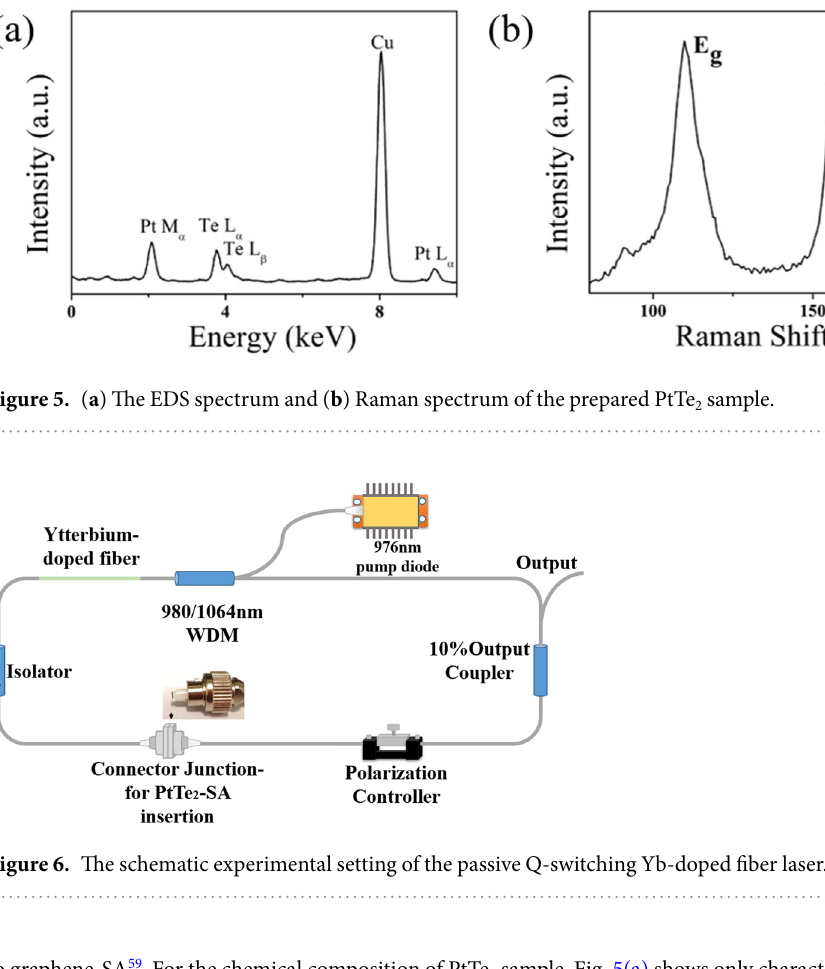
to graphene-SA 59 . For the chemical composition of PtTe 2 sample, Fig. 5(a) shows only characteristic peaks from Pt or Te and no other observable impurities is found (Cu peak is induced from the copper mesh support for TEM measurement). Meanwhile, as shown in Fig. 5(b), the Raman-active modes E g and A 1g were positioned at 110.7 cm − 1 and 154.8 cm − 1 , respectively, and which agree well with the previous report 57 . The E g mode is repre- senting the in-plane vibration mode of Platinum and Ditelluride atoms. Meanwhile, the A 1g is standing for the out-plane vibration modes of Ditelluride atoms. These strong characteristic Raman peaks reveal that the fabri- cated PtTe 2 nanosheets possess with good crystallinity. For the laser test, a pure Polyvinyl alcohol (PVA) film, which possess of identical thickness as the PtTe 2 -PVA SA film, was first inserted between the connector junction of the ring cavity as shown in Fig. 6 to act as a control experiment set. No Q-switched laser pulses were observed by modifying the polarization direction of the polarization controller (PC) and pumping power. It confirms Q-switching operation cannot be obtained by using pure PVA polymer or cavity phase self-modulation. Further on, the fabricated PtTe 2 -SA was cut with a size in approximately 1 mm × 1 mm, and was intro- duced into the laser system by sandwiching between two fiber connectors. The parasitic reflection could be eliminated by using FC/APC connector and thus improved the stability of the Q-switching system. Stable Q-switched pulse train was observed as the pump power elevated to the starting threshold of 118 mW. However, when the pump power raised beyond 146.5 mW, the Q-switched output was vanished due to the over saturation of the absorber at high input fluence 26,60 . The average output power was measured as from 1.03 mW to 2.48 mW with respect to the pump power from 118 mW to 146.5 mW as shown in Fig. 7(a). The modula- tion ranges of the pulse width (Full width at half maximum) and the repetition rate are 13.6 μ s to 5.2 μ s and 23.0 kHz to 33.5 kHz, respectively as shown in Fig. 7(b). The fluctuation of repetition rate and output power of the Q-switched laser are less than 5% within the test time of about 30 to 45 minutes during the measurement. The minimum pulse duration can be further shortened by either enhancing the modulation depth of the SA or reduc- ing the total length of ring cavity 61 . The maximum recorded single pulse energy is about 74.0 nJ which is compa- rable to previous literature of passive Q-switching Yb-doped fiber laser with utilizing another TMDs based SA, for instance, MoSe (resolution bandwidth: 20 Hz) and wavelength spectra has shown in Fig. 7(c–f) corresponding to the maximum output single pulse energy of 74.0 nJ. The passively Q-switched Yb-doped fiber laser based on PtTe 2 saturable absorber was first demonstrated. A stable Q-switched operation was illustrated from 1066 nm fiber ring cavity. The achieved pulse duration and rep- etition rate range are 13.6 μ s to 5.2 μ s and 23.0 kHz to 33.5 kHz, respectively, with correlated to the average output